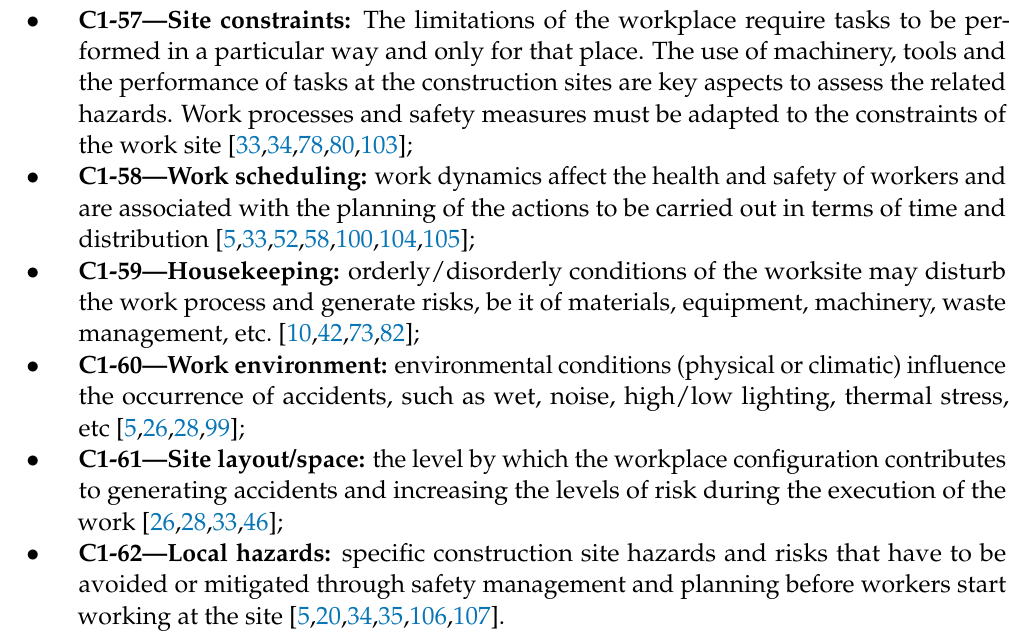
Figure 9. Percentage distribution of factors in the “Construction site (C)” category.